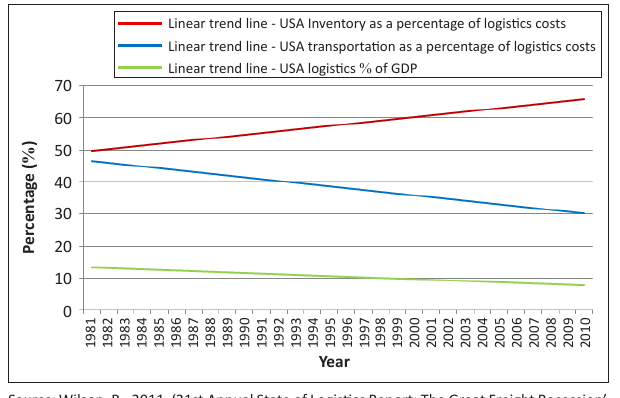
FIGURE 2: Linear trends of logistics cost components in the USA.